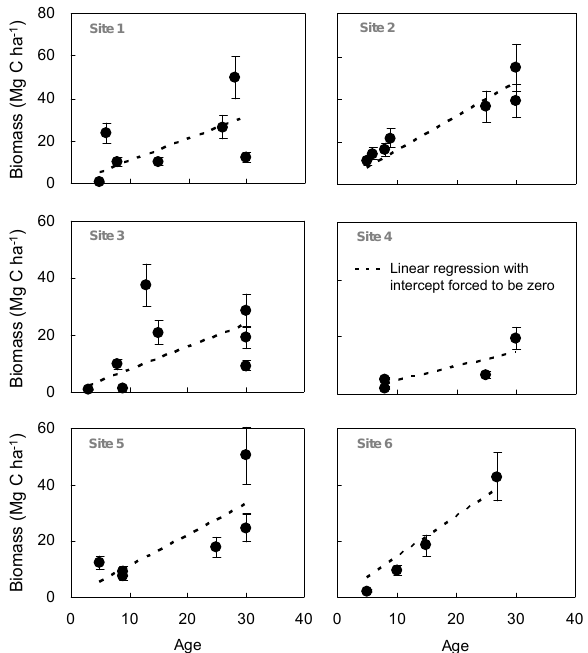
Fig. 4. The changes of total carbon biomass of the plantations with stand age (including floor vegetation but excluding fine root) at the six sites. Error bars are standard deviations.